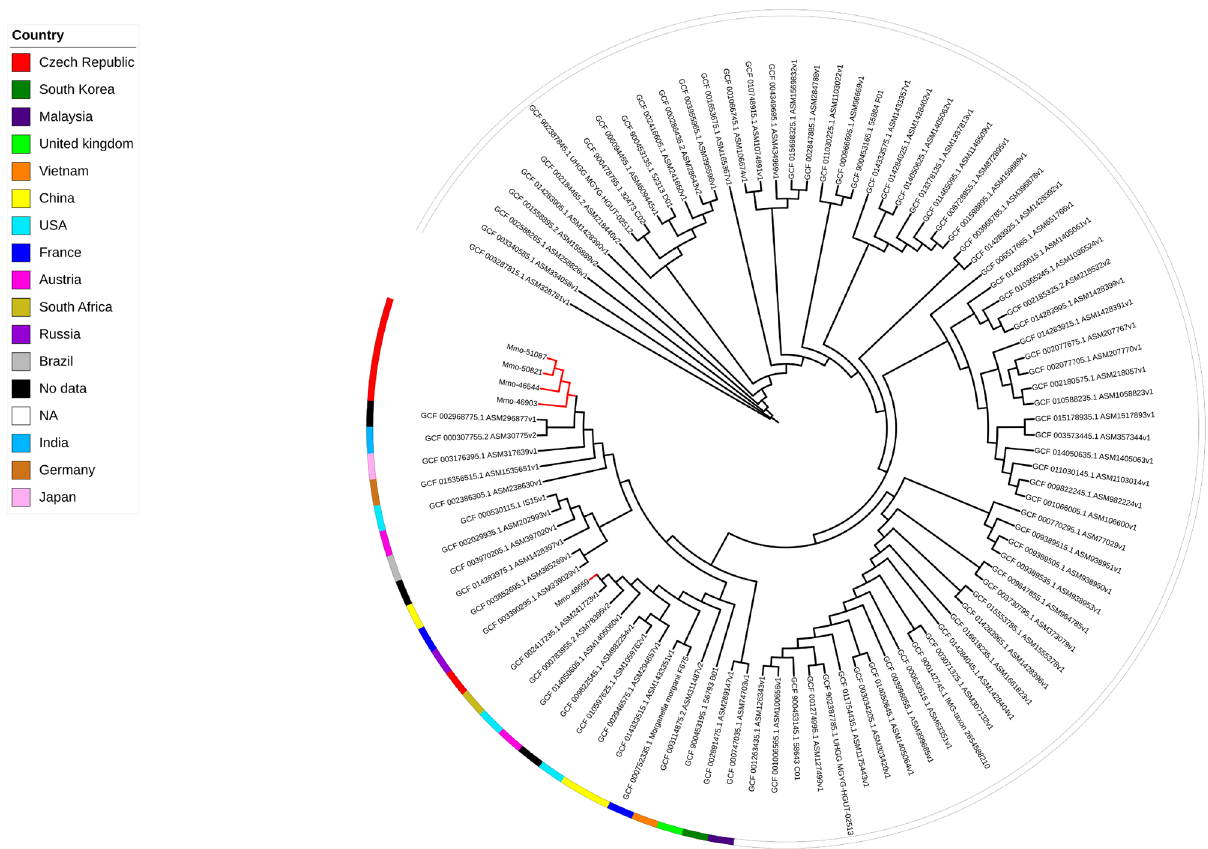
Figure 5. SNPs-based phylogeny of the five M. morganii with 92 genomes downloaded from NCBI database. Red nodes indicate the Isolates from the